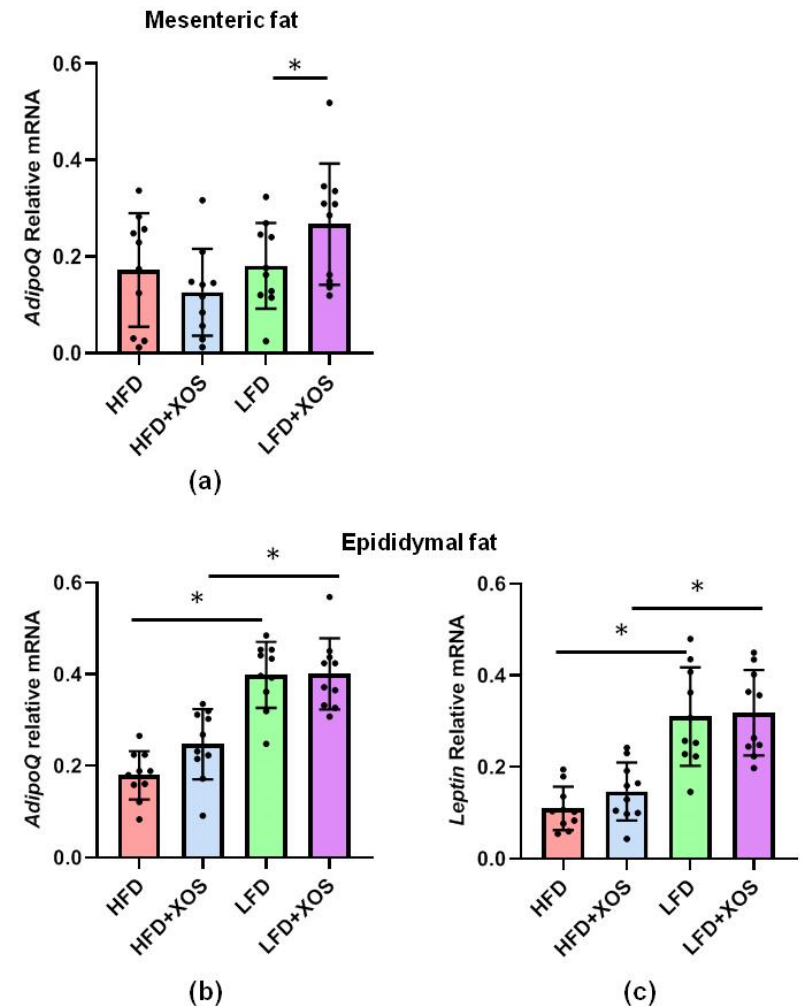
Figure 12. On the HFD, XOS did not affect the expression of leptin or adiponectin mRNA. The diet or XOS had no main effects on the expression of ( a ) adiponectin (AdipoQ) mRNA in the mesenteric adipose tissue, but on the LFD, XOS had an increasing effect on its expression. In the epididymal adipose tissue the diet but not XOS had an effect the expression of ( b ) leptin and; ( c ) AdipoQ mRNA. n = 8–10/diet group. The different data points are shown with black dots in all graphs. * indicates statistically significant difference between the groups in all graphs.